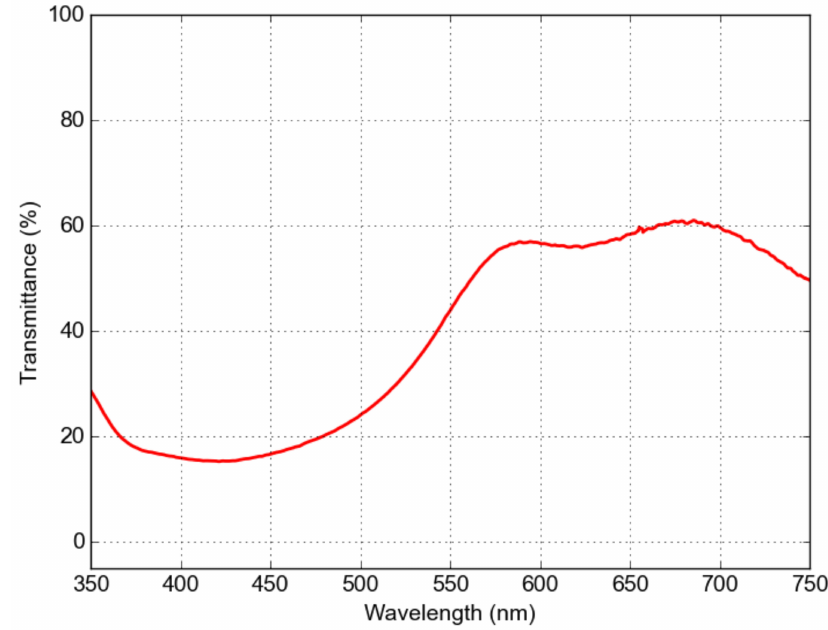
Figure 12. Transmission spectrum of Eu 3+ -doped (15%) LaF 3 nanocomposite LaF 3 .